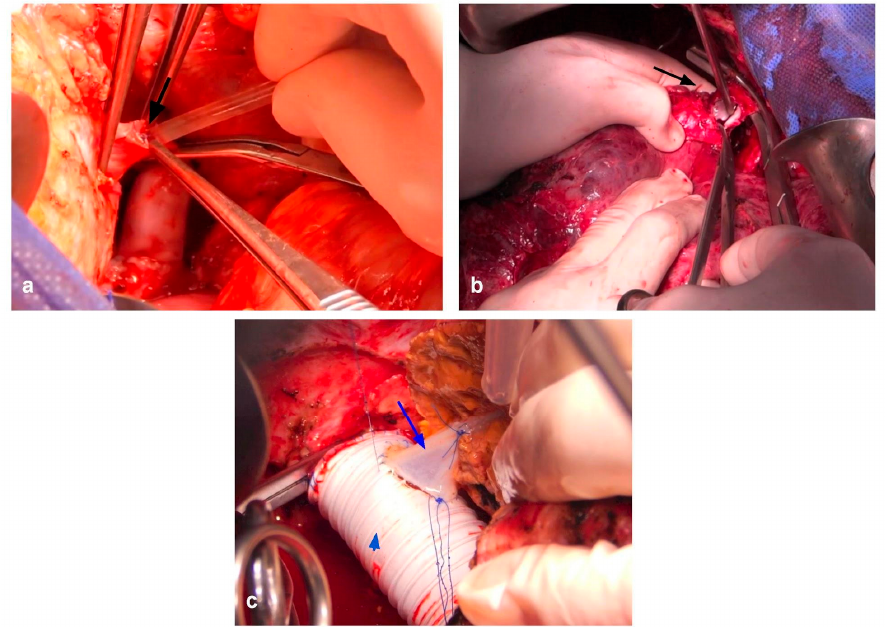
Figure 7. The ante situm procedure in a patient with a large CRLM invading the hepatocaval confluence. ( a ) Portotomy is performed and cannulated for cold perfusion with Wisconsin University Solution (black arrow). ( b ) The liver is rotated in a counterclockwise fashion to expose the hepatocaval confluence. A piggy-back type clamping of the hepatic veins is performed, and the left hepatic vein is opened (black arrow). ( c ) Reconstruction of the IVC with a prosthetic graft (arrowhead) and reimplantation of the left hepatic vein using a deceased donor iliac vein graft (blue arrow) are performed.